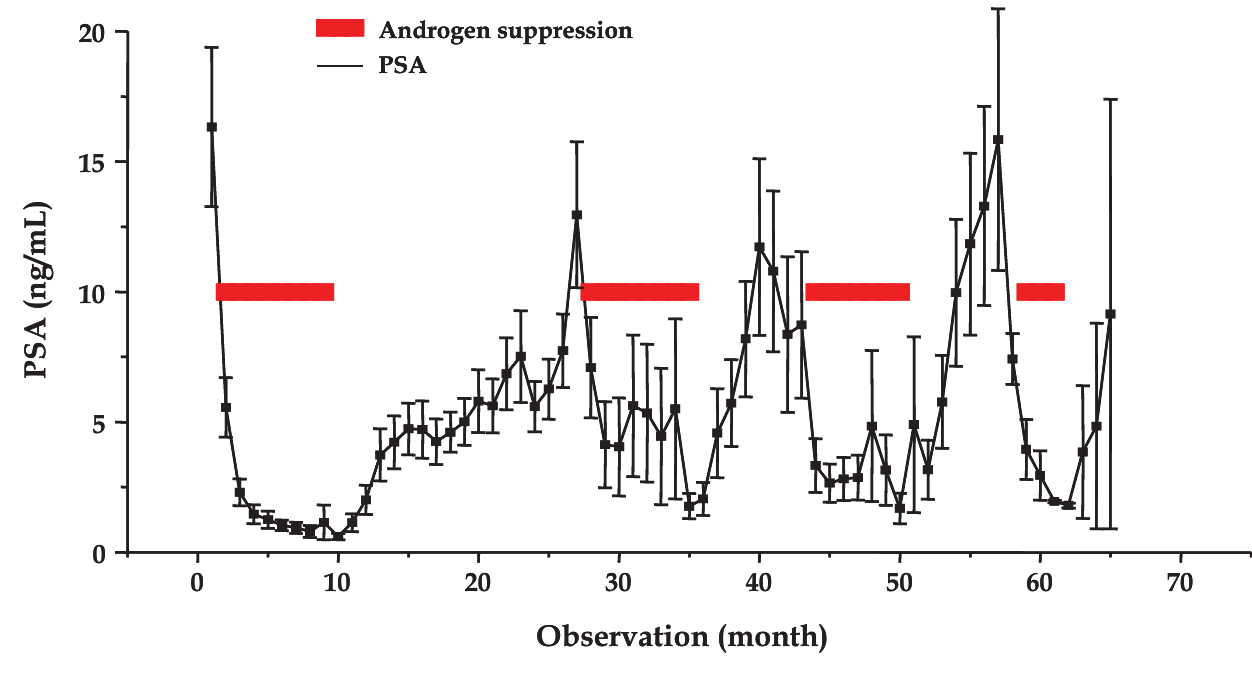
Figure 2. Mean time course of PSA during four IAS cycles of the prostate cancer patient group in total (observations monthly, mean values ± SEM). Red bars indicate the four AS